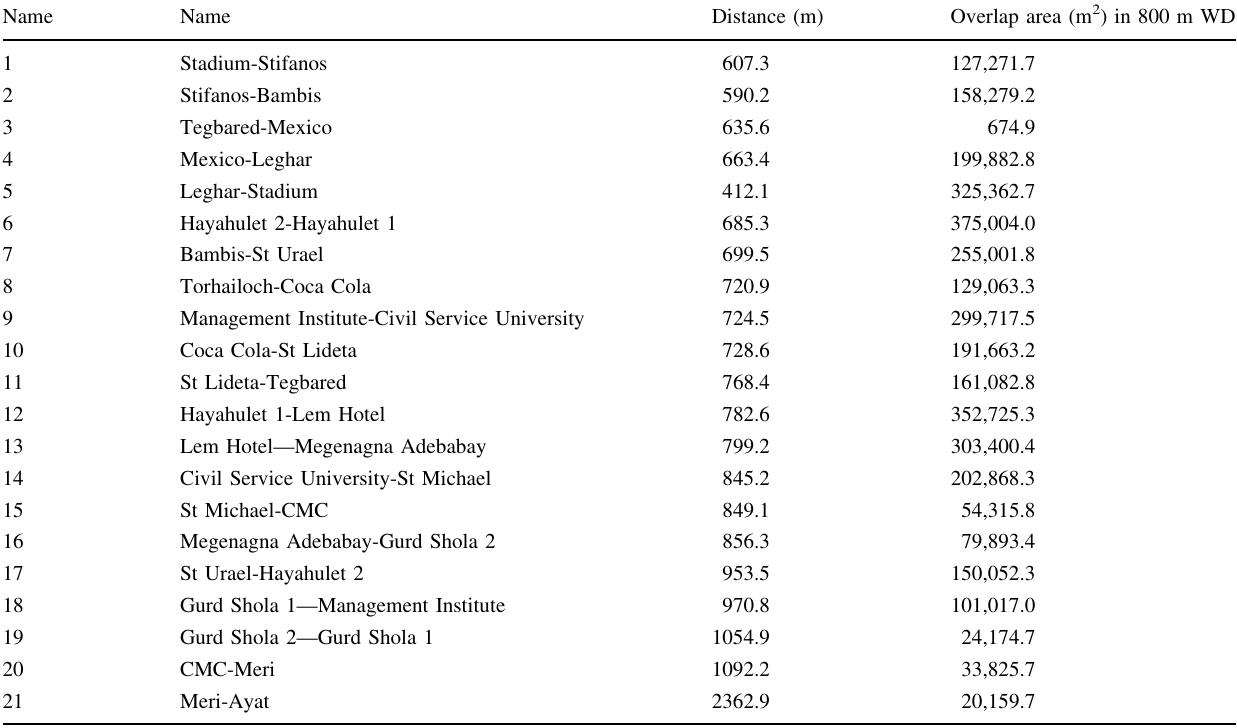
Table 2 Distance between consecutive stations and overlap areas between respective service